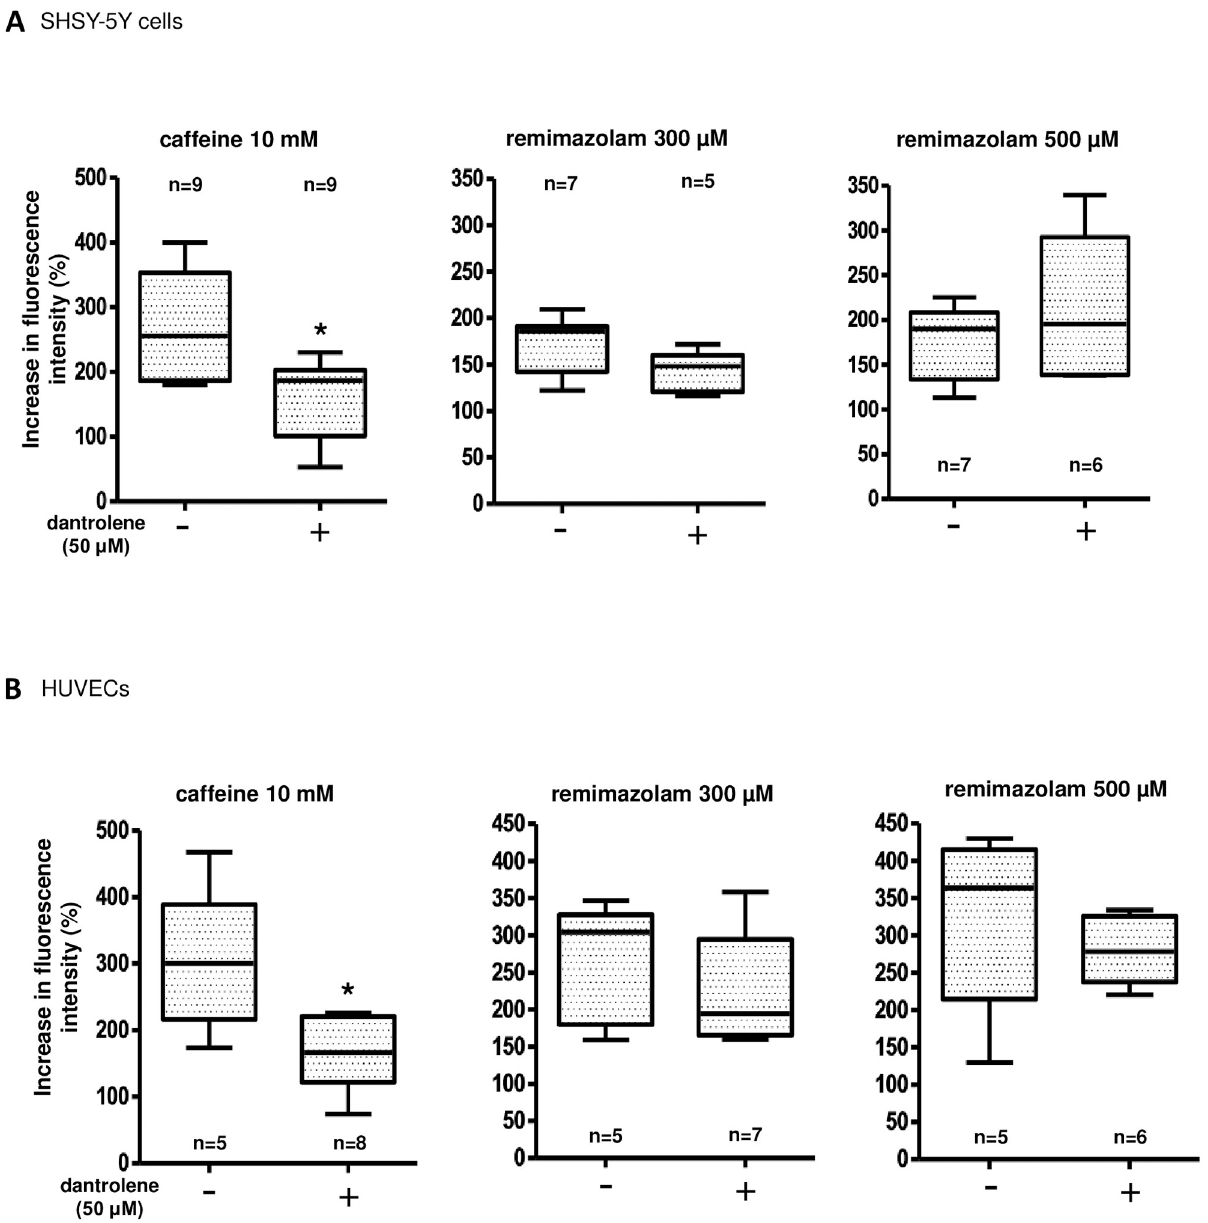
Fig 8. Characterization of remimazolam-induced calcium elevation; possible involvement of ryanodine receptors. (A) Caffeine, a ryanodine receptor (RYR) agonist, at 10 mM induced the intracellular calcium in SHSY-5Y cells. Fifteen minutes-pretreatment with dantrolene, a RYR antagonist, at 50 μ M significantly inhibited the caffeine-induced calcium mobilization (n = 9, � p = 0.024, compared to control, Mann Whitney test), however, 15 minutes-pretreatment with dantrolene at 50 μ M did not significantly influence the 300 and 500 μ M remimazolam-induced calcium elevation (n = 5–7, p = 0.149, compared to control, Mann Whitney test, and n = 6–7, p = 0.5338, compared to control, Mann Whitney test, respectively). The horizontal line in each box indicates the median, the box shows the interquartile range (IQR), and the whiskers represent 1.5 × IQR. (B) Caffeine at 10 mM induced the intracellular calcium in HUVECs. Fifteen minutes-pretreatment with dantrolene at 50 μ M significantly inhibited the caffeine-induced calcium mobilization (n = 5–8, � p = 0.0186, compared to control, Mann Whitney test), however, 15 minutes-pretreatment with dantrolene at 50 μ M did not significantly influence the 300 and 500 μ M remimazolam-induced calcium elevation (n = 5–7, p = 0.5303, compared to control, Mann Whitney test, and n = 5–7, p = 0.2468, compared to control, Mann Whitney test, respectively). The horizontal line in each box indicates the median, the box shows the interquartile range (IQR), and the whiskers represent 1.5 × IQR.